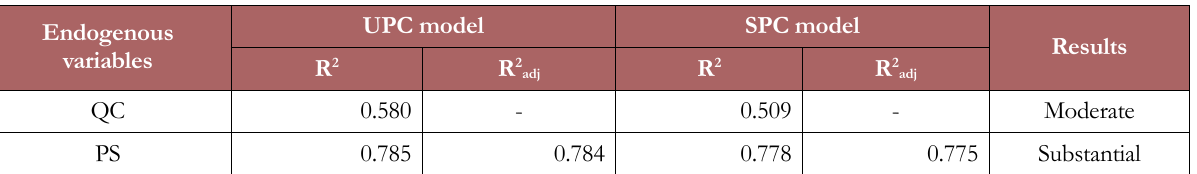
Table 9. Coefficients of determination R 2 and R 2